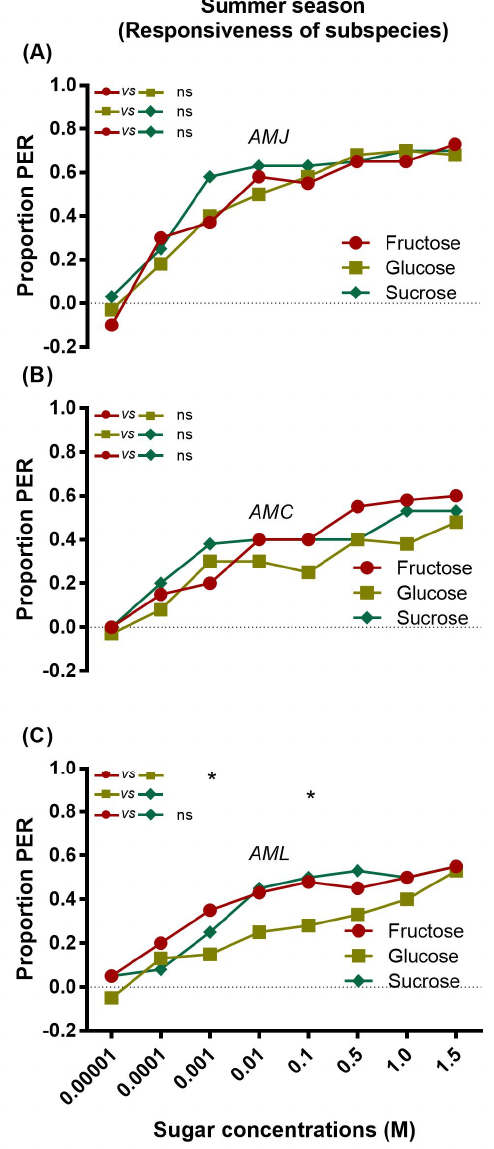
Figure 1. Sugar responsiveness of single honey bee subspecies AMJ ( A ), AMC ( B ) and AML ( C ) to fructose, glucose, and sucrose during the summer season. Asterisks indicate the significant difference ( x 2 or Fisher’s exact test * p < 0.05) for the responses of single honey bee subspecies AMJ ( A ) AMC ( B ) and AML ( C ) against different concentrations of the respective sugar (fructose vs. glucose, glucose vs. sucrose and fructose vs. sucrose).